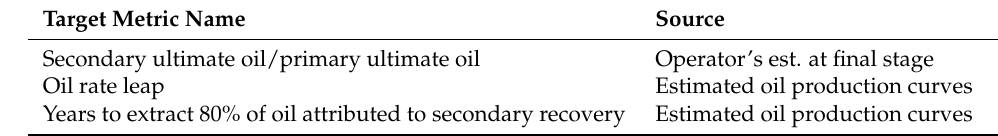
Table 2. Waterflooding effect